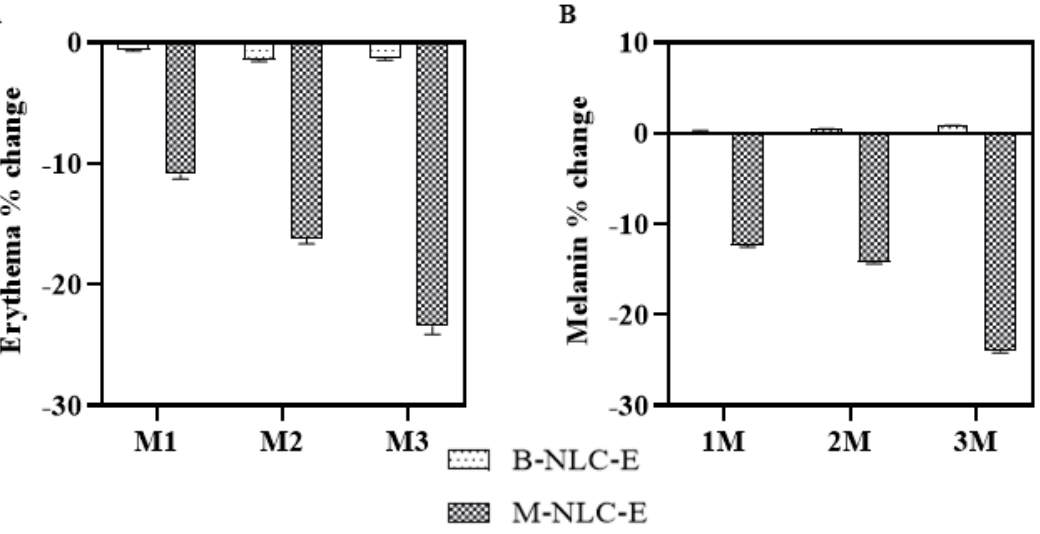
Figure 12. Erythema ( A ) and Melanin contents ( B ) change after 1st (M1), 2nd (M2) and 3rd month (M3) of use of B-NLC-E and M-NLC-E.